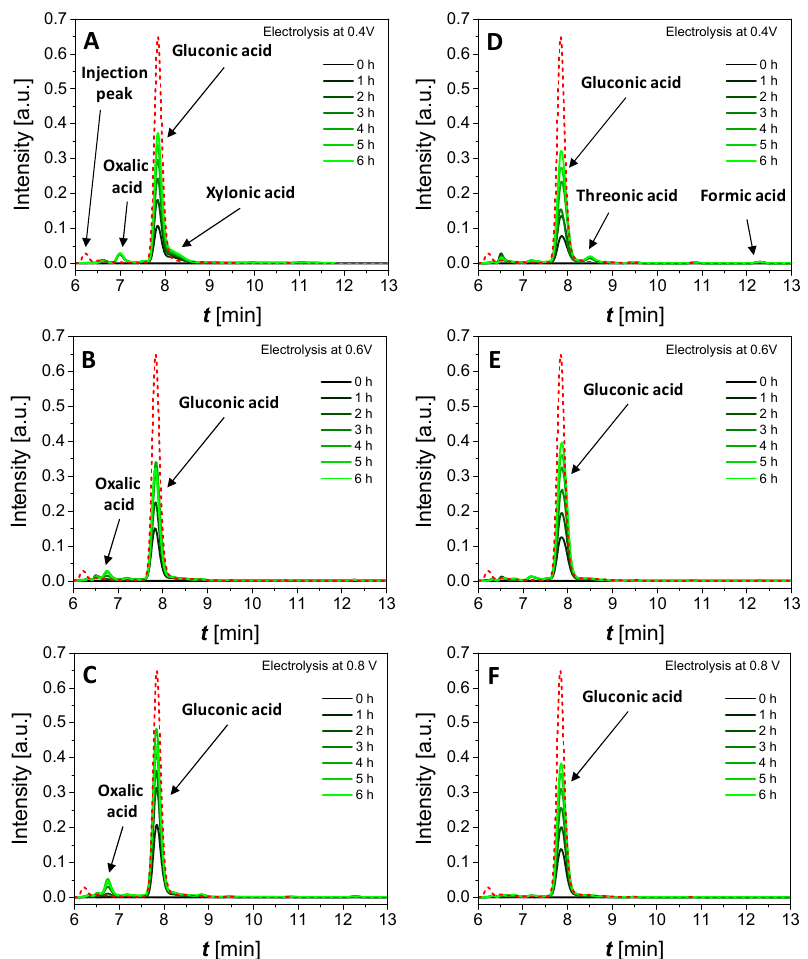
Figure 7. Chromatograms recorded as a function of time (every hour from 0 to 6 hours of chronoamperometry) for the electro-reforming in 0.10 mol L − 1 NaOH solution of ( A ) 0.10 mol L − 1 glucose at +0.4 V, ( B ) 0.10 mol L − 1 glucose at +0.6 V, ( C ) 0.10 mol L − 1 glucose at +0.8 V, ( D ) 0.50 mol L − 1 glucose at +0.4 V, ( E ) 0.50 mol L − 1 glucose at +0.6 V and ( F ) 0.50 mol L − 1 glucose at +0.8 V. The sodium gluconate standard (0.10 mol L − 1 ) is presented in red.